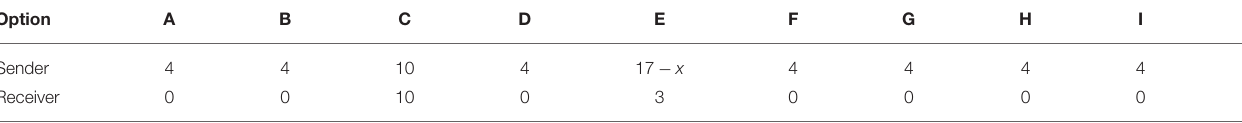
TABLE 1 | Example payoff table in the sender-receiver games (amounts in euros).